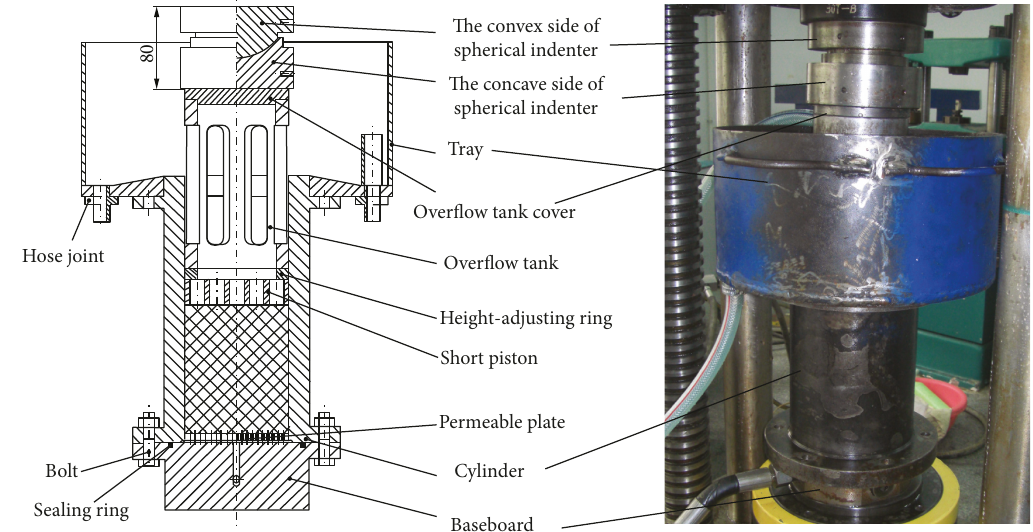
Figure 2: Schematic and photo of the open